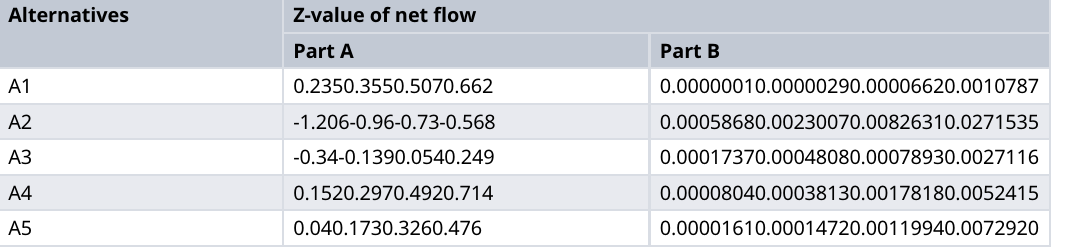
Table 11. Z-number based net